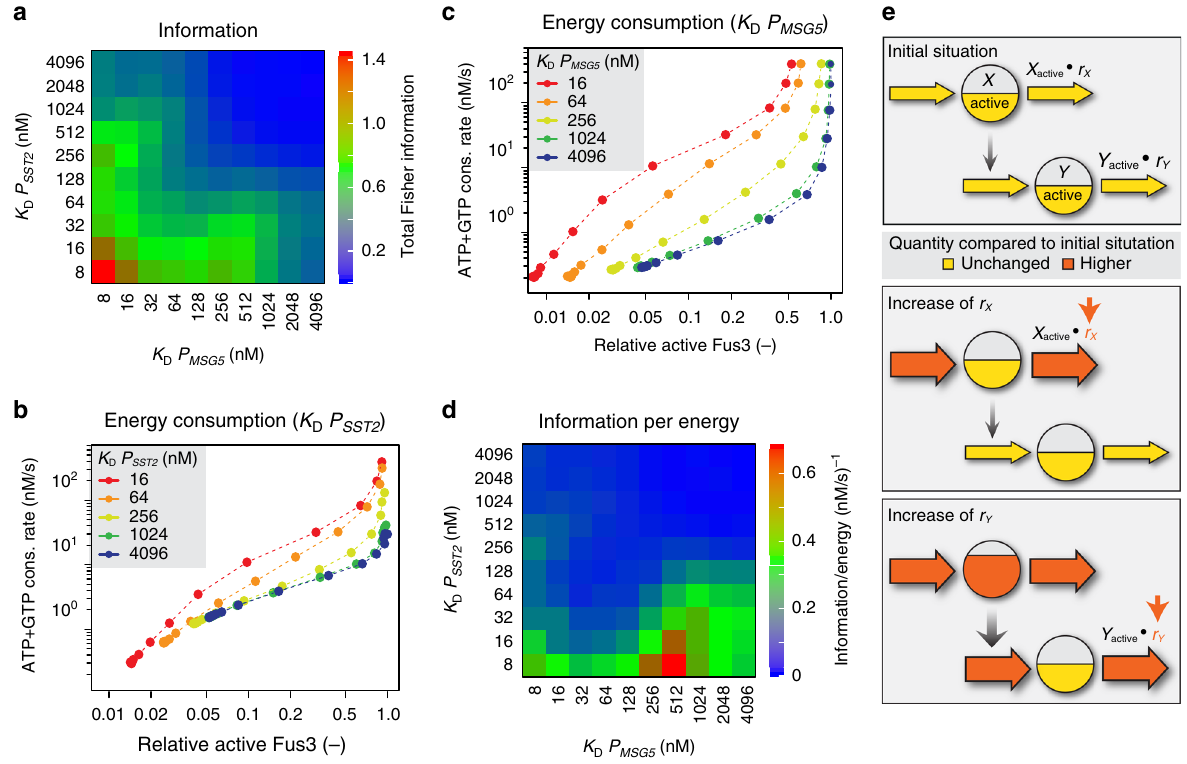
Fig. 4 Induction of negative feedback regulators may balance accuracy versus energy investment. a Simulated dependence of pathway accuracy (information) on sensitivities of SST2 and MSG5 induction. The heat map shows total Fisher information of active Fus3 (Fus3-PP) over the same 5 × 10 6 range of stimulus strength (see main text and Supplementary Fig. 8 for details) for varying binding af fi nities ( K D ) of Ste12-P to SST2 and MSG5 promoters. b , c Simulated energy (ATP + GTP) consumption rates as a function of relative active Fus3 (Fus3-PP normalized to maximum per plot) for different induction sensitivities of SST2 ( b ) and MSG5 ( c ). Binding af fi nities of Ste12-P to SST2 and MSG5 promoters were changed individually while keeping af fi nity to the respective other promoter fi xed at 8 nM. d Simulated dependence of information per energy on sensitivities of feedback induction. The heat map shows total Fisher information per energy (see text for details) simulated as in a . e Cartoon illustrating difference between energetic costs of negative feedback regulation at two stages of a simulated signalling cascade. Here, activities of two consecutive positive regulators ( X and Y ), indicated by fi lling heights of the respective circles, are determined by the in fl ux (e.g. phosphorylation) and out fl ux (e.g. dephosphorylation) rates of energy. In fl ux rates at the upper (lower) level depend on the signal strength (e.g. pheromone stimulation) and activity of the upstream regulator, respectively. Out fl ux rate constants ( r X , r Y ) correlate with the activities of negative regulators (e.g. phosphatases). Red colour indicates increase in quantities compared to the initial situation (upper panel). In order to sustain constant cascade output Y active while increasing r x (middle panel), the increased out fl ux requires compensation by higher in fl ux into X (i.e. stronger stimulation is required to achieve the same output). In this case, increased fl ux of energy solely at the affected level is suf fi cient for compensation. However, when increasing r Y (lower panel), the compensatory higher in fl ux into Y additionally requires an increase in X active , which in turn requires higher in fl ux into X . Thus compensation of increased r Y entails increased energy fl uxes on both cascade